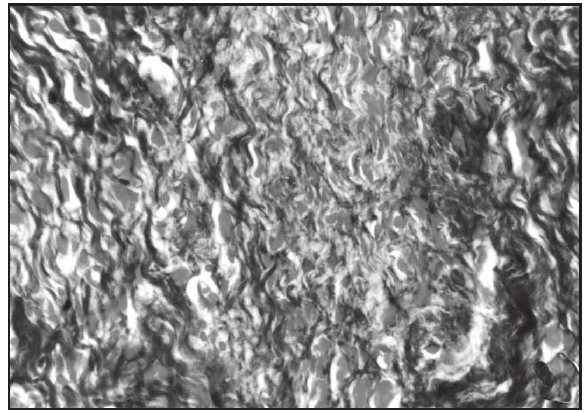
Figura 6 – Caso 2/tricrômio de Masson. Citoplasma das células neoplásicas corando-se em vermelho vivo. Entretanto, notar nesse caso a menor intensidade da coloração